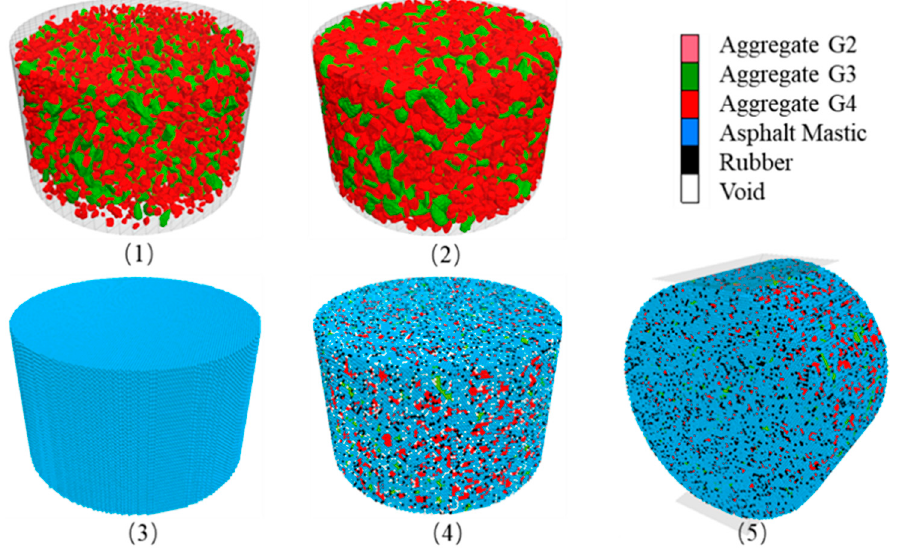
Figure 10. Model setup process of the rubber modified HMA: ( 1 ) clumps generation process; ( 2 ) diameter expansion procedure of clumps; ( 3 ) HCP balls generation process; ( 4 ) setup of di ff erent group of HCP balls; ( 5 ) indirect tensile test process.